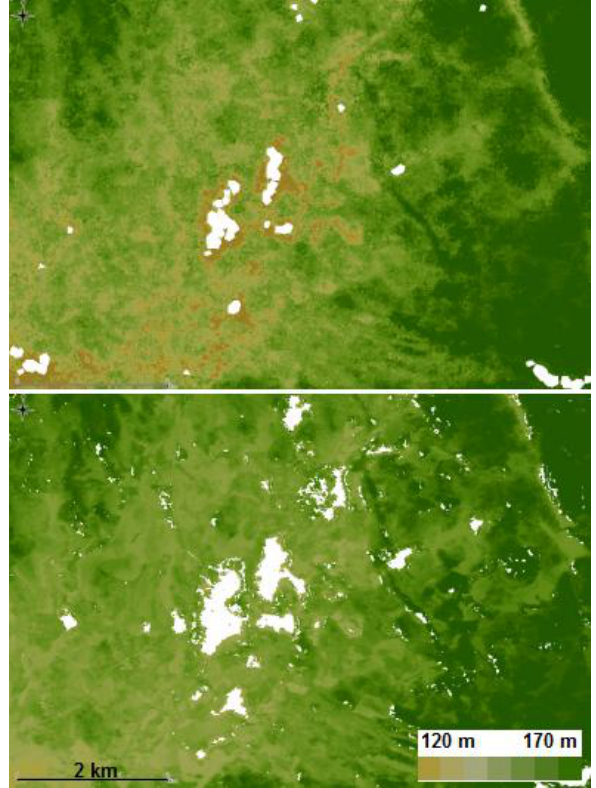
Figure 2. TSX DSM (top) and TDX DSM (bottom). The terrain height is included in the values. No data areas are white. Statistics of the TDX and TSX based 3D metrics for all test plots are presented in Table 4 . On average, the InSAR plot mean tree height was 1.0 m higher than in the TSX point cloud. On the other hand, the maximum plot tree height was 3.6 m lower in the InSAR point cloud. The standard deviation in the TSX stereo-radargrammetric data (4.7 m) is higher than in TDX InSAR data (2.5 m). The plot mean heights from TSX and TDX are compared in Figure